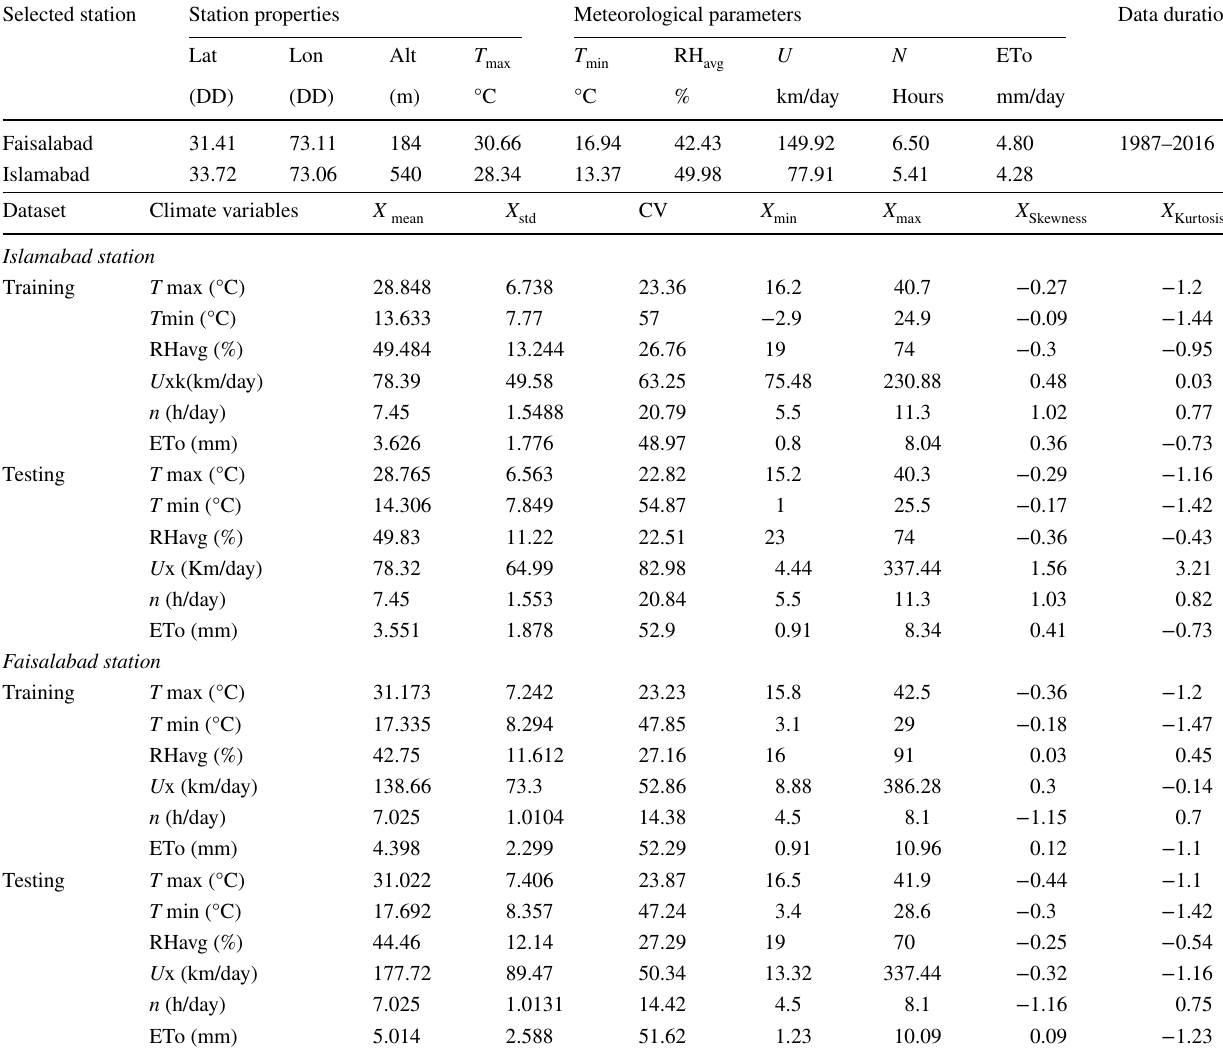
Table 1 Parameter of the selected algorithms Selected station Station